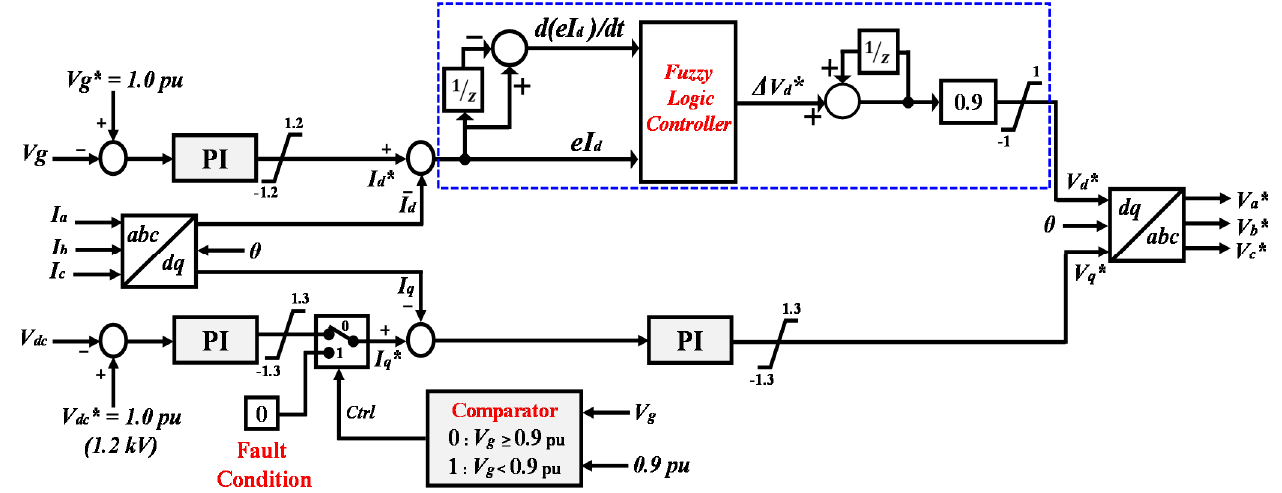
Figure 5. Proposed FLC-based cascaded GSC controller.